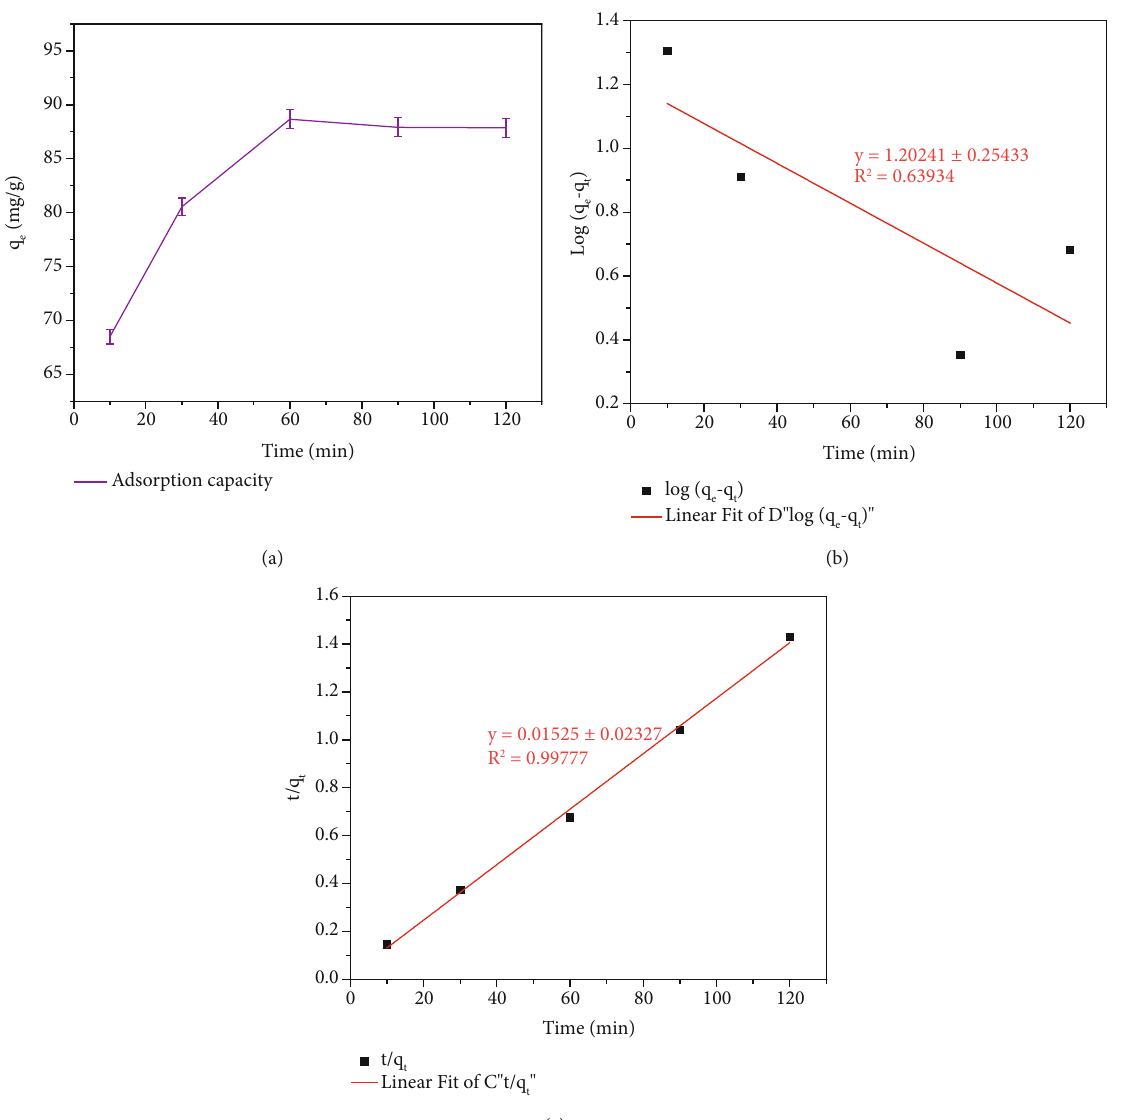
Figure 7: (a) Impact of contact time on removal of Pb(II). (b) Pseudo- fi rst-order. (c)